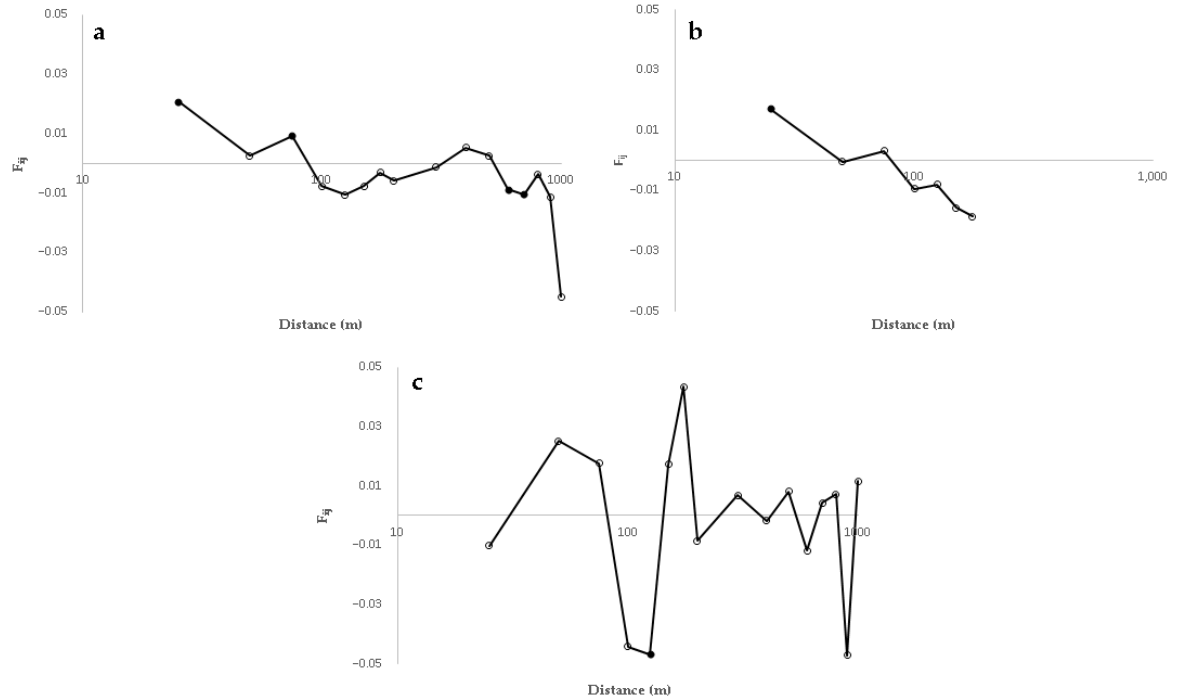
Figure 6. Average kinship coefficients F ij plotted against the logarithm of geographical distance (m) for the whole forest ( a ), and independently performed for the northern area ( b ) and the southern area ( c ). Note the different distance range of each analysis. Significant values ( p < 0.05) above and below confidence intervals are represented with filled symbols.